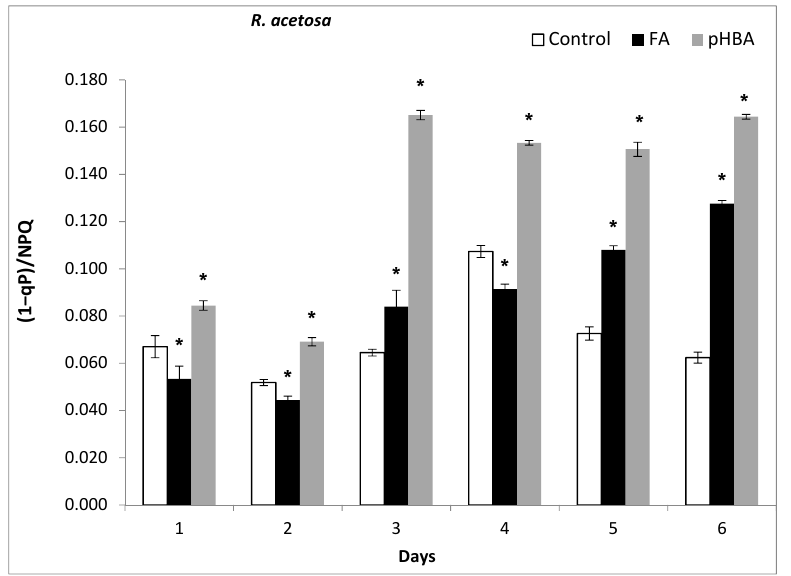
Figure 4. Changes in photon energy dissipated (1 − qP)/NPQ) in leaves of Rumex acetosa from days 1–6 following exposure to FA, pHBA. Every bar in the graph represents the mean (± S.E.) of three replicates. * Asterisks indicate significant differences at p ≤ 0.05 with respect to control.